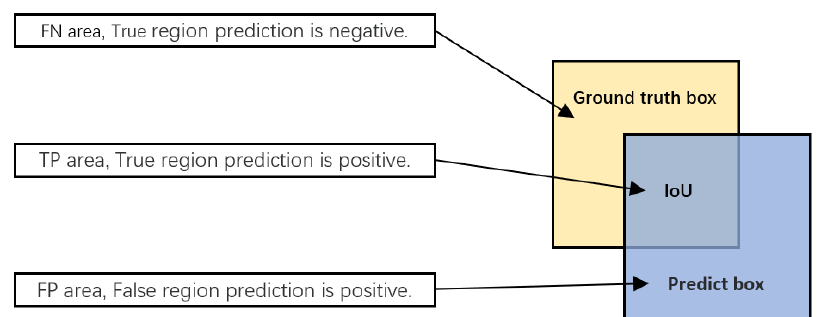
Figure 9. IoU stands for Intersection over Union. Ground truth box denotes the true label of the dataset object. Predict box denotes the result of the model predicting the object.